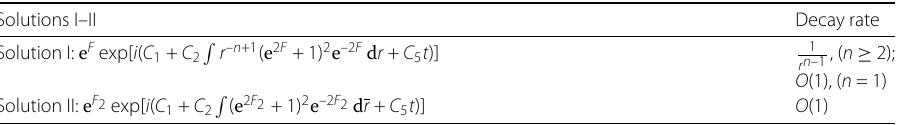
Table 4 Variable separation solution of the equivalent LLG equation without damping (see equation (60)). F satisfies (71); F 2 is the solution of